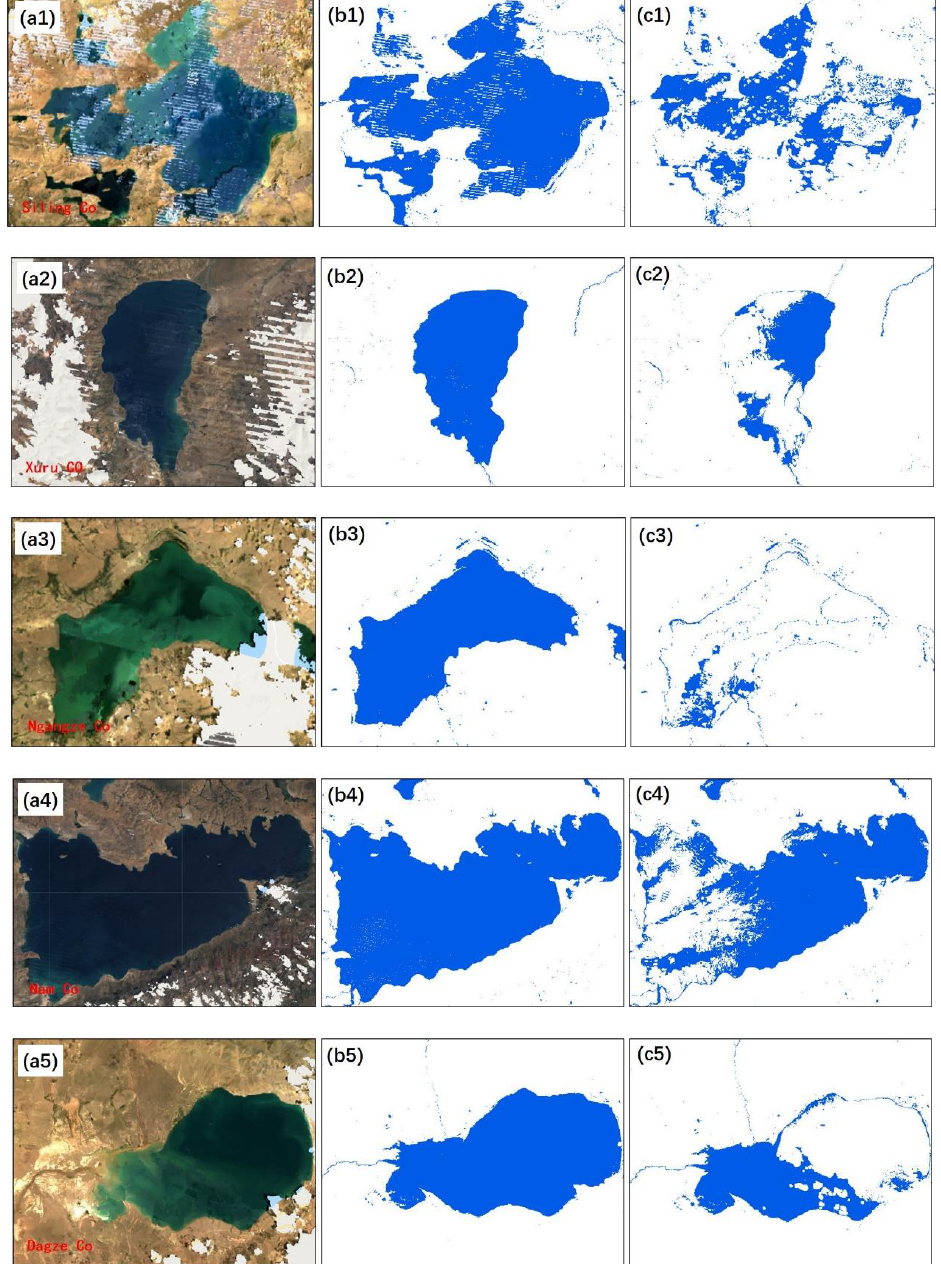
Figure 7. Comparison of water extraction results from TOA image and SR image ( a1 – a5 are Landsat 7/8 images, b1 – b5 are water extraction results from TOA images, and c1 – c5 are water extraction results from SR images).